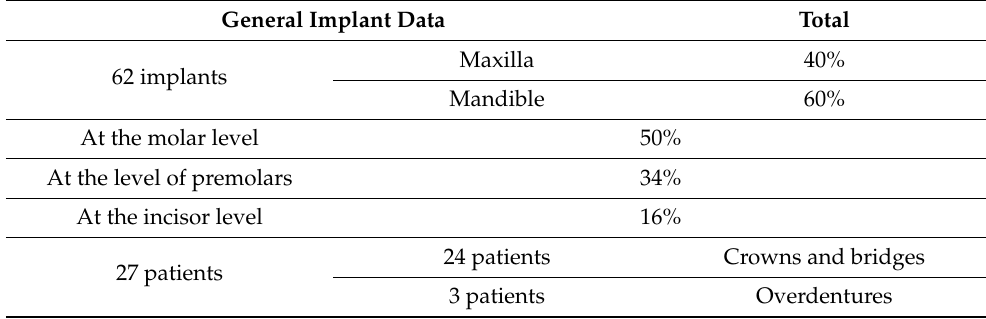
Table 2. General implant